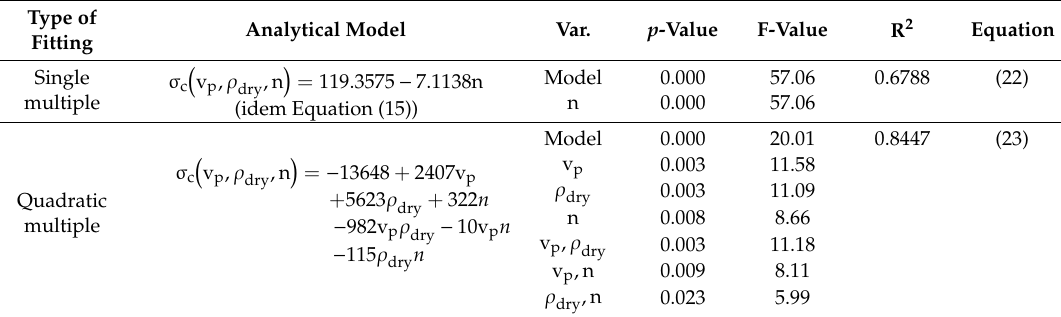
Table 5. Summary of the multivariate analytical